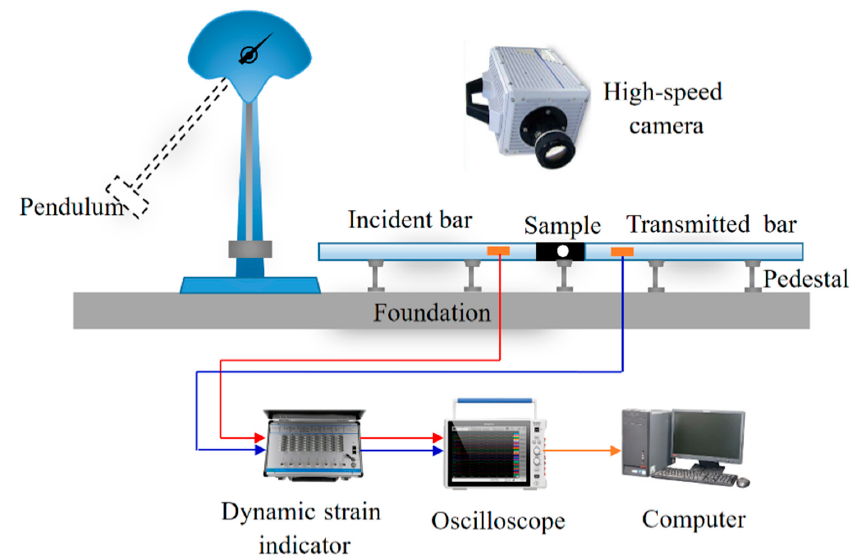
Figure 2. SHPB apparatus and monitoring system.